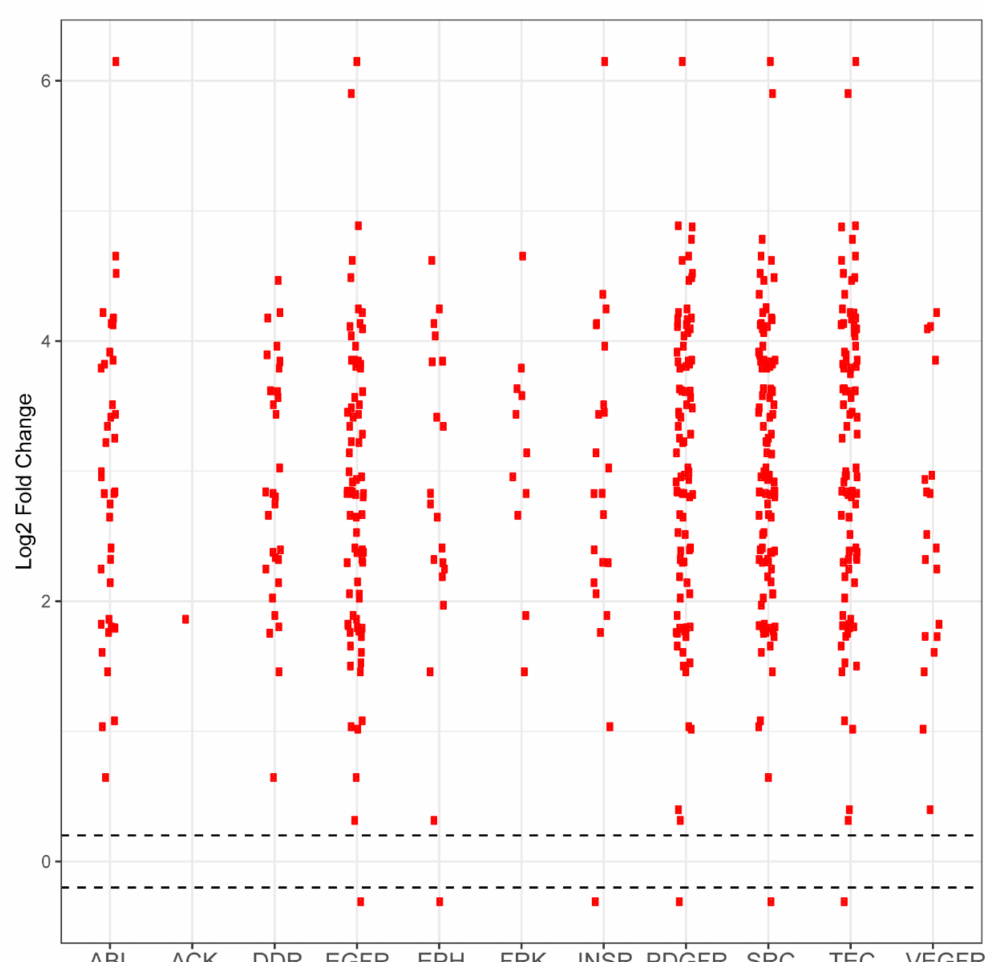
Figure A2. Di ff erential phosphorylation levels of peptide sequences attributed to kinase family activity in PDCL15 vs. wild-type control. Each red dot in a column represents one peptide sequence whose phosphorylation is performed by that column’s kinase family. The y axis reports log2-fold change and the x axis identifies the kinase family. Black dots represent peptides that did not demonstrate di ff erential phosphorylation in PDCL15 samples compared to wild-type samples, with the dashed horizontal line representing a positive or negative 0.2 log2-fold change cuto ff . Red dots above these lines represent peptides that are more phosphorylated in PDCL15 compared to control. Red dots that are below these lines represent peptides that are less phosphorylated in PDCL15 compared to